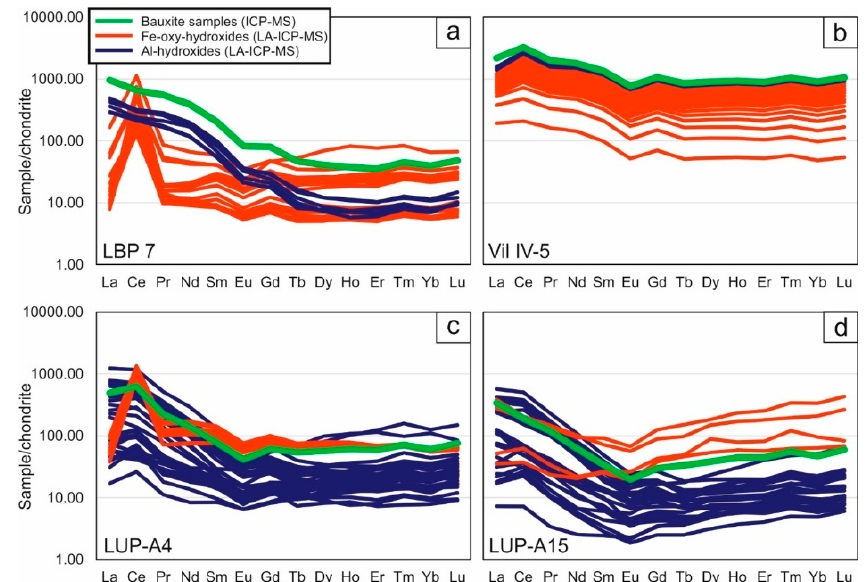
Figure 5. Boxplots reporting the compositions (mg/kg) of selected elements in the analyzed Fe ‐ oxy ‐ hydroxides. Individual LA ‐ ICP ‐ MS analyses are given in Table S3.